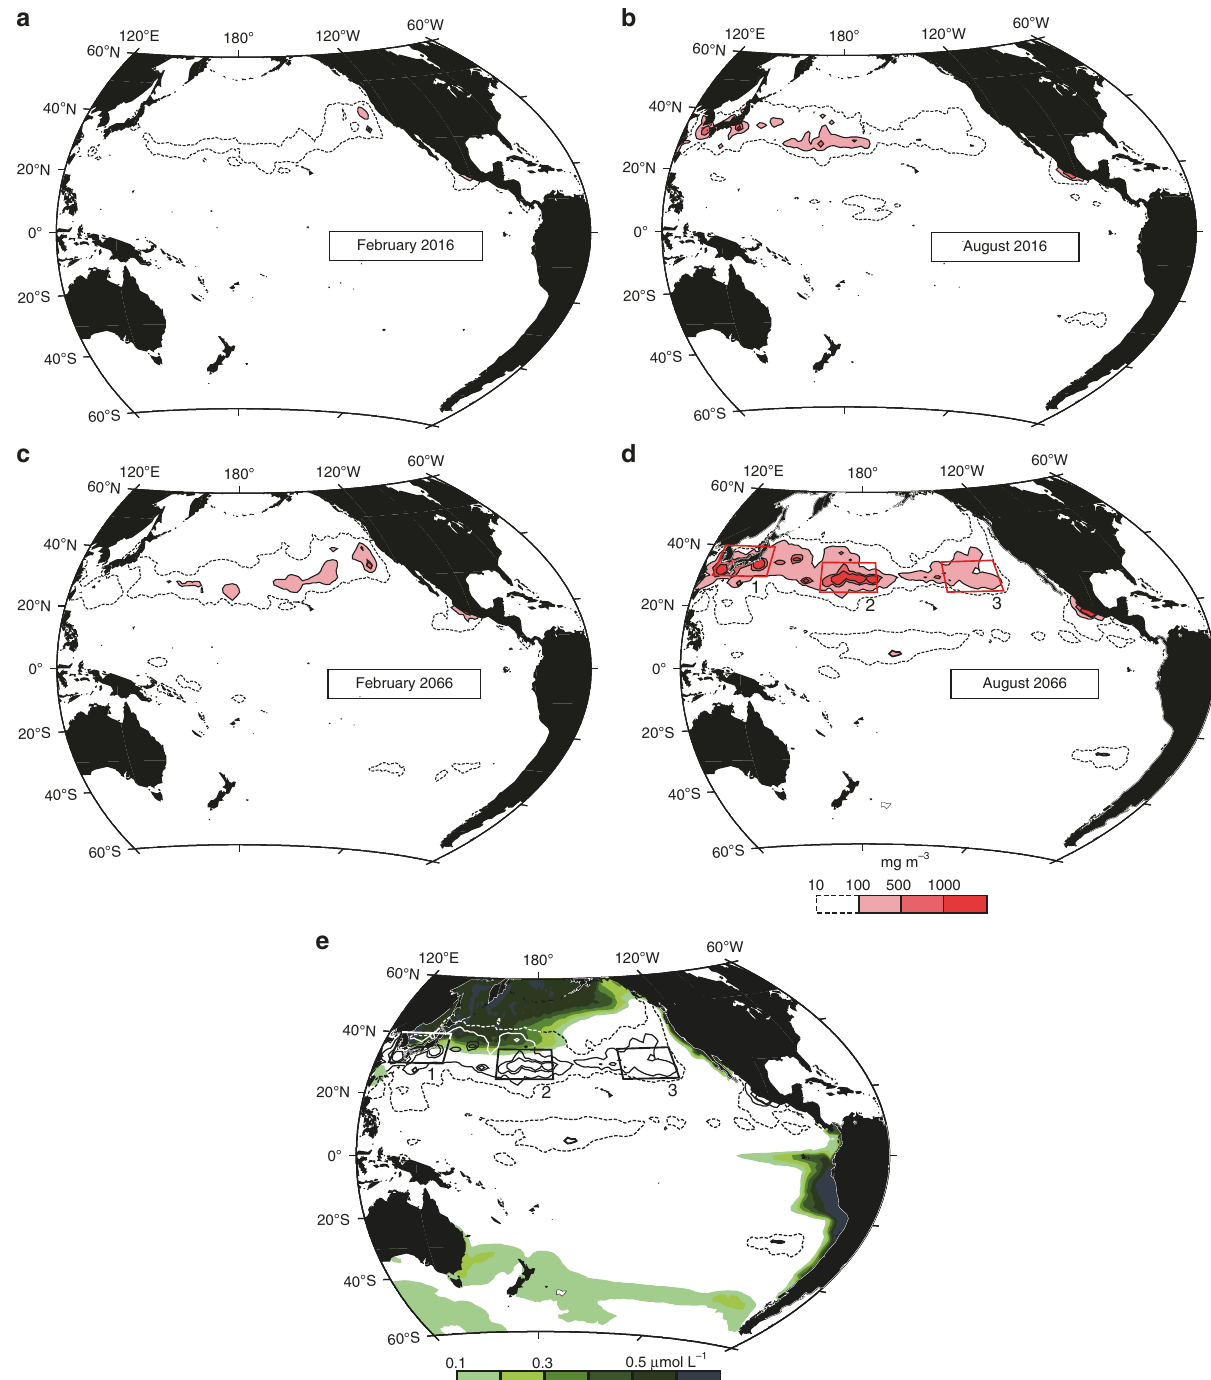
Fig. 6 Abundance of microplastics in the present and future. The panels represent the weight concentrations averaged in February ( a ) and August ( b ) in 2016, and February ( c ) and August ( d ) in 2066 at the sea surface. The weight concentrations are shown by a red stippling in the line with the scale at the bottom of d . The broken curves denote a weight concentration of 10 mg m – 3 . The green stippling in e represents surface zooplankton concentrations provided by the Estimated Ocean State for Climate Research dataset 39,40 (see the bottom of the panel for the scale). The zooplankton data were averaged over the boreal spring and summer seasons (April – September) from 2002 to 2011. Also shown by contours in e are the weight concentrations in length of each irregularly shaped fragment visible on the monitor display and were Conversion of metrics to a particle count per unit area . We thereafter converted measured using image-processing software (ImageJ downloaded from http:// the microplastic concentration to a total particle count (particle count per unit imagej.nih.gov). Particle counts within each size category were divided by the area; pieces km − 2 ) by vertically integrating the concentrations at all depths using volume of seawater fi ltered during each tow to convert them to particle counts per the wind speed and signi fi cant wave heights measured during each microplastic unit seawater volume (concentration with the unit of pieces m − 3 ; Supplementary survey (wind/wave correction). This was undertaken because light-weight micro- Fig. 7). We obtained the concentration of all microplastics at each station by plastics are likely to be vulnerable to vertical mixing caused by oceanic turbulence, integrating the concentrations of fragments with sizes ranging from 0.3 to 5mm. and because concentrations observed using a neuston net are largely dependent on